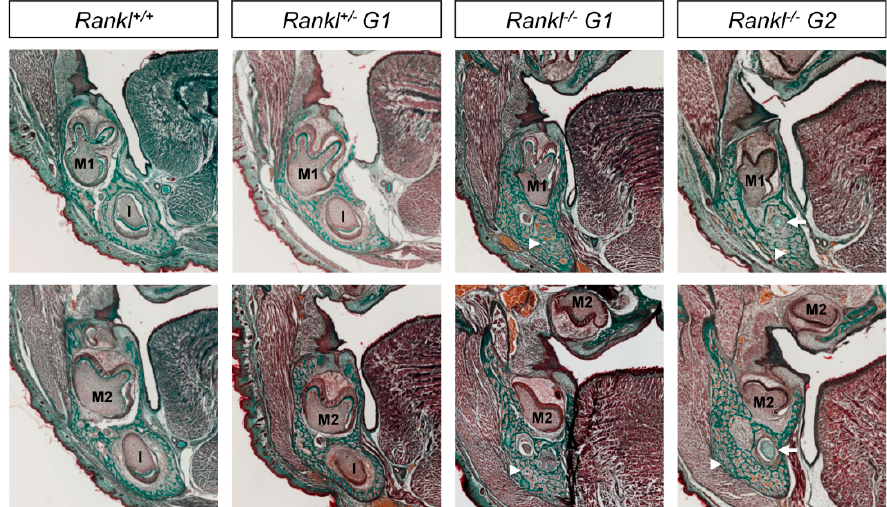
Figure 1. MicroCT comparative analysis of the craniofacial skeletons of first- and second-generation Rankl null mutant mice. Second-generation null mutants had enlarged foramen (stars and arrowheads) compared with first-generation null mutants. Percentage of closure measures (surface) for the different genotypes are 89 ± 2 for +/+, 84 ± 3 for +/ − , 67 ± 4 for G1 − / − and 57 ± 5 for G2 − / − . Moreover, the mandibles of second-generation null mutants appeared flat, with missing proximo-distal curvature (dotted lines). Angle of the mandible curvature measures (opening degrees) for the different genotypes are 134 ± 9 for +/+, 136 ± 11 for +/ − , 139 ± 9 for G1 − / − and 163 ± 7 for G2 − / − . No difference was observed between the wild type and heterozygous pups. Numbers of pups: 4 +/+, 8 G1+/ − , 5 G1 − / − , and 5 G2 − / − .